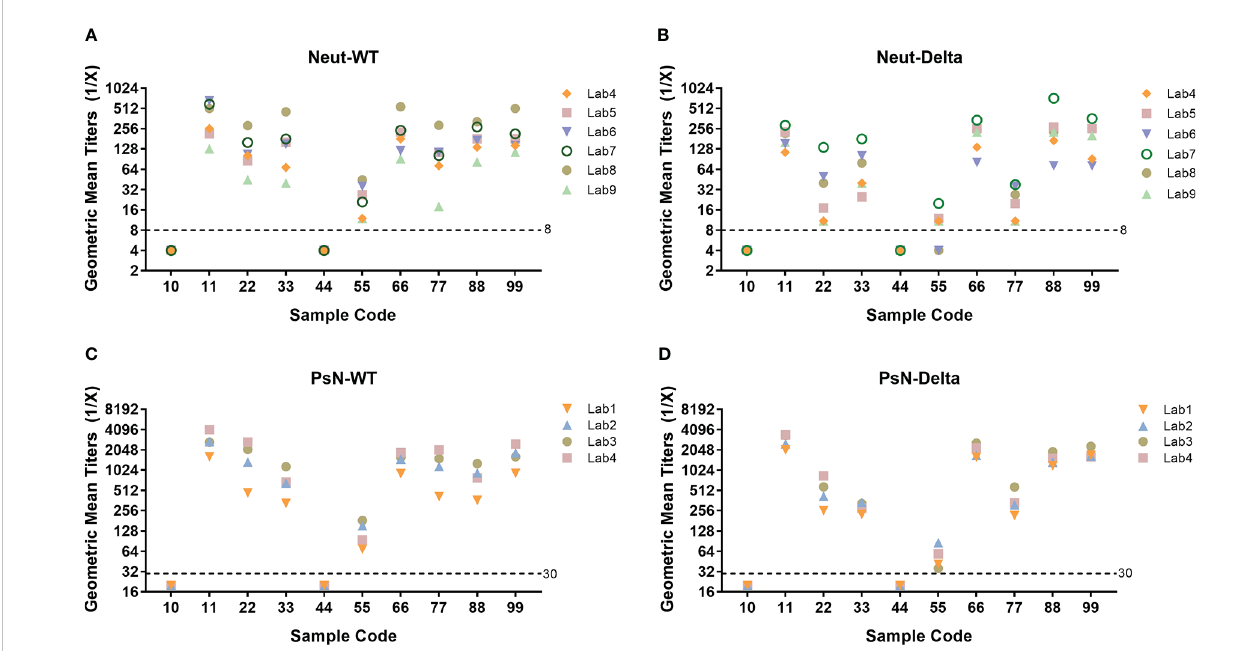
FIGURE 1 Neutralizing antibody (NtAb) geometric mean titers (GMT) of all collaborative calibration study samples across all participants. (A) Live virus neutralization assay (Neut), WT strain; (B) Neut assay, Delta variant; (C) Pseudovirus neutralization assay (PsN), WT strain; (D) PsN assay, Delta variant. Nine laboratories with experience in testing SARS-CoV-2 NtAbs participated in this collaborative calibration study. The Neut method was adopted by six laboratories, and the PsN method was adopted by four laboratories. In each laboratory, three independent and effective tests were performed on all samples using the WT and Delta strains, respectively. All laboratories returned results according to